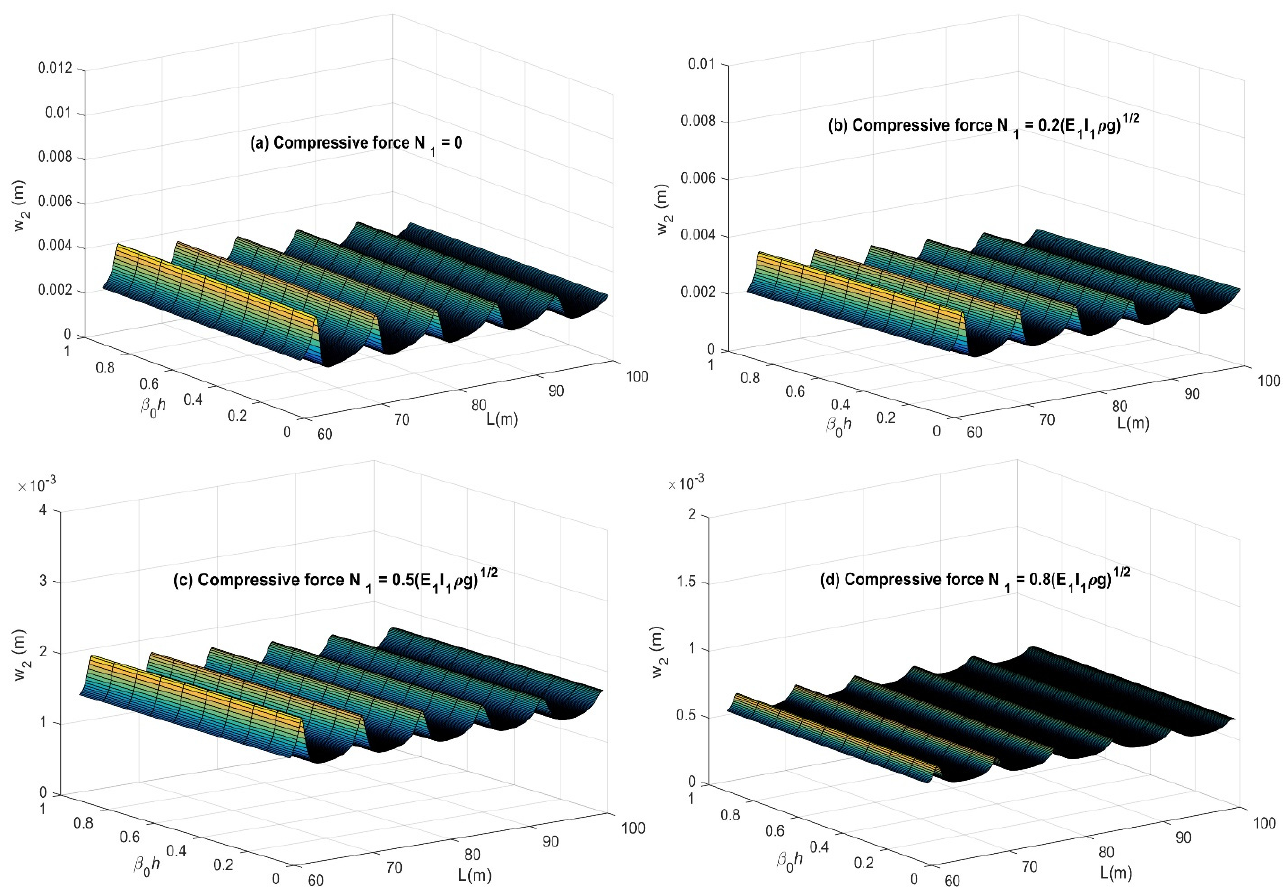
Figure 10. Porous plate displacement with floating flexible plate for different compressive forces with θ = 60 ( deg. ) versus β 0 h and L ( m ) 0